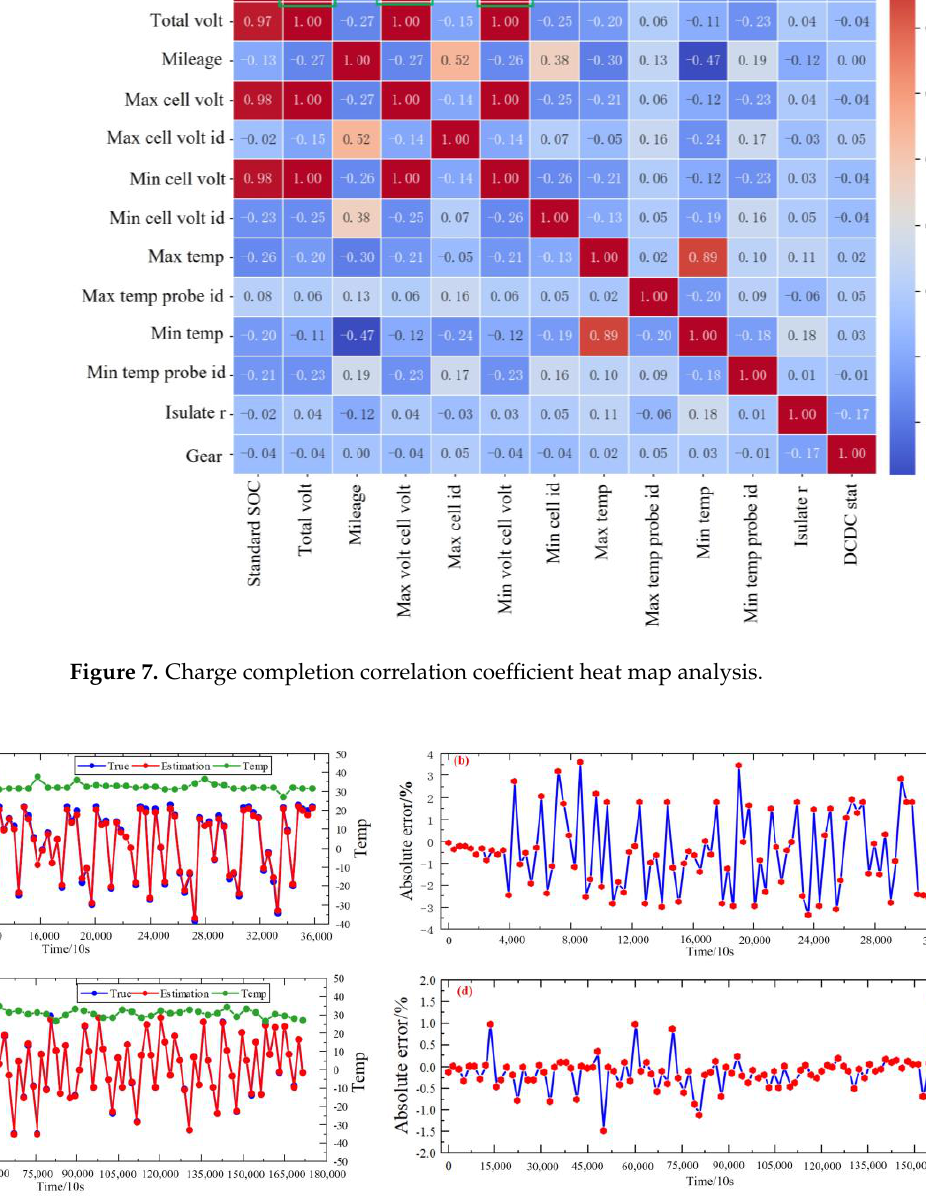
Table 3. SOC estimation result error in three different operating conditions.